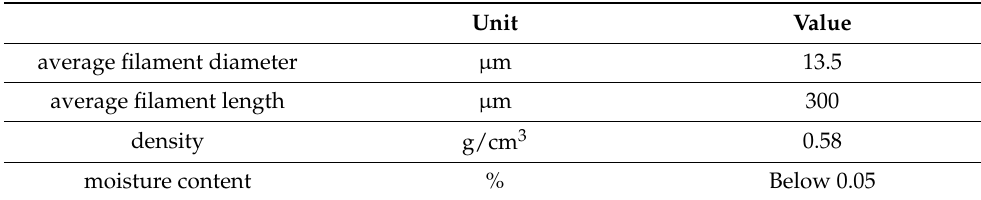
Table 1. The physical properties of milled glass fiber. Unit Value average filament diameter µ